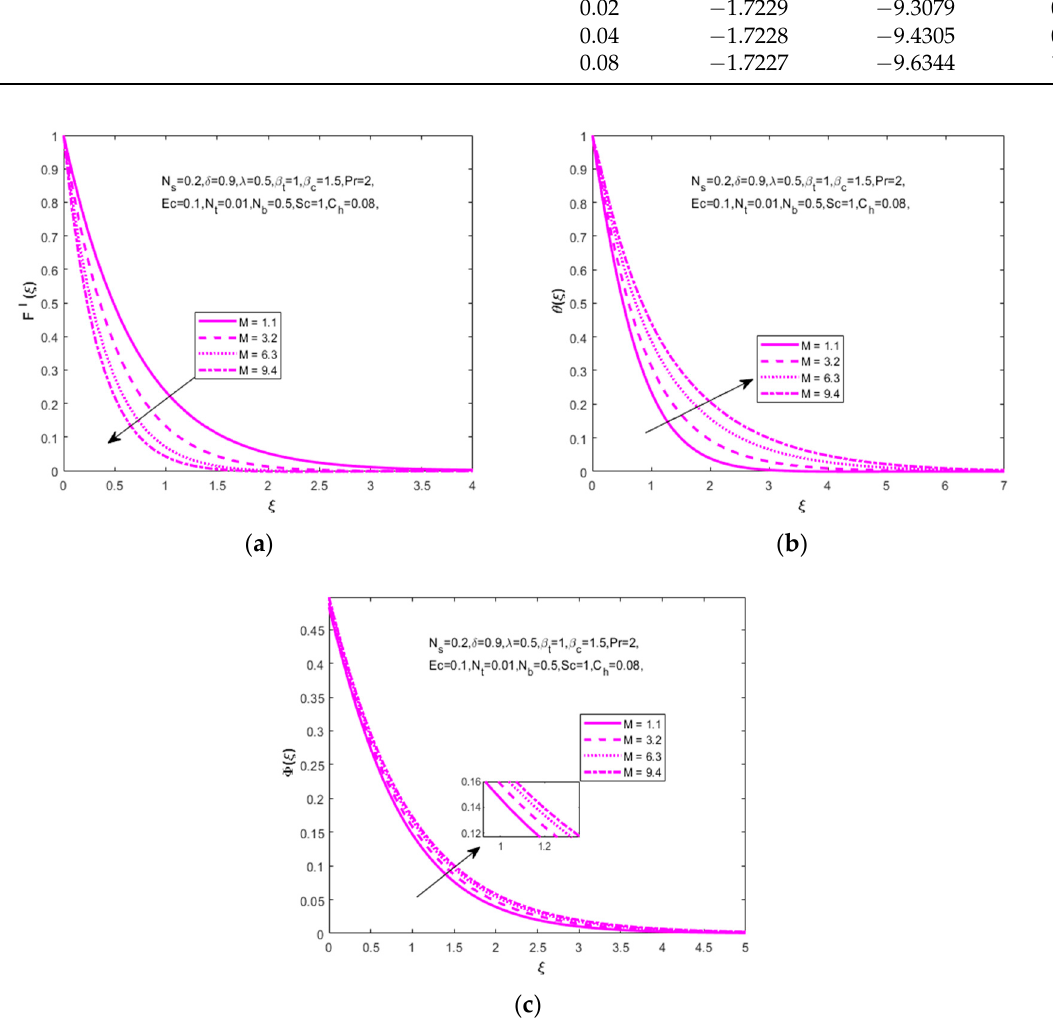
( c ) ξ′ θξ Figure 2. Effect of magnetic parameter M on ( a ) velocity ( ( )), F ( b ) temperature ( ( )) and Figure 2. Effect of magnetic parameter M on ( a ) velocity ( F (cid:48) ( ξ )) , ( b ) temperature ( θ ( ξ )) and ξΦ ( c ) concentration ( Φ ( ξ )) , , respectively. ( c ) concentration ( ( ))